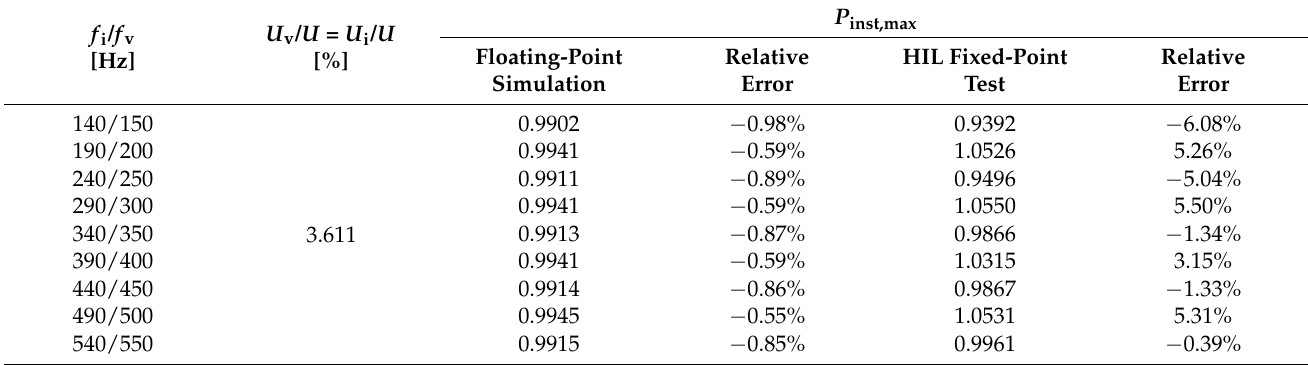
Table 6. Bandwidth test using harmonic and interharmonic sideband modulation.